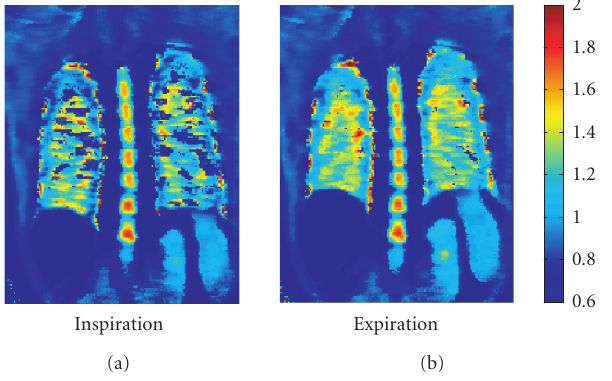
Figure 1: T1 map of a healthy subject: expiration (b) demonstrates a lengthening of the T1 times (seconds) as compared to inspiration (a).